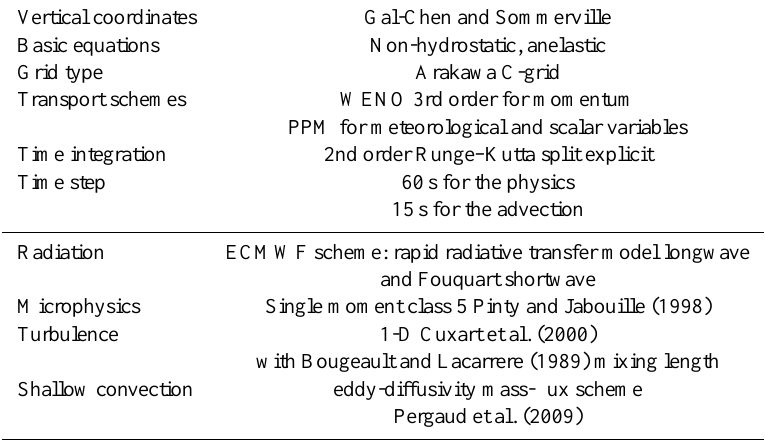
Table 2. Dynamical and physical options used in the Meso-NH